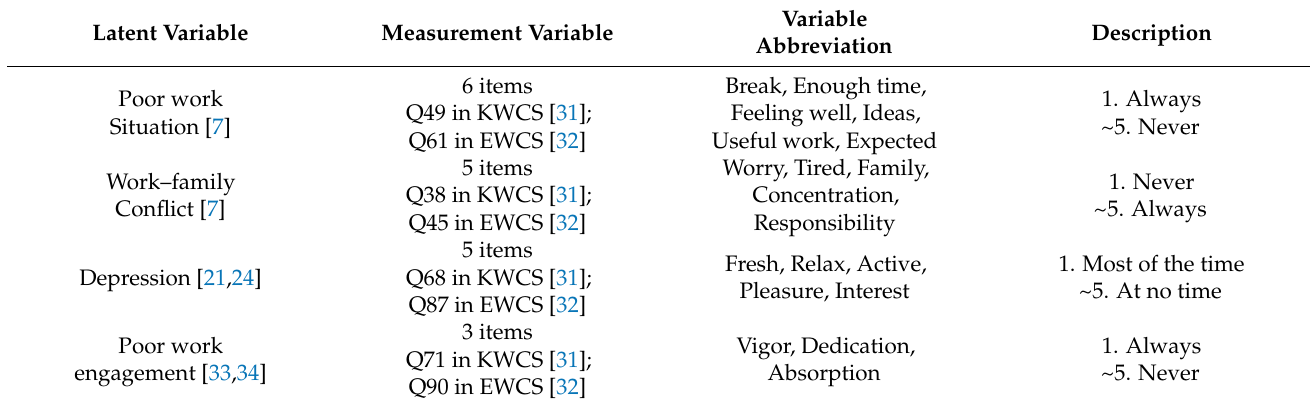
Table 1. Latent variables and measurement